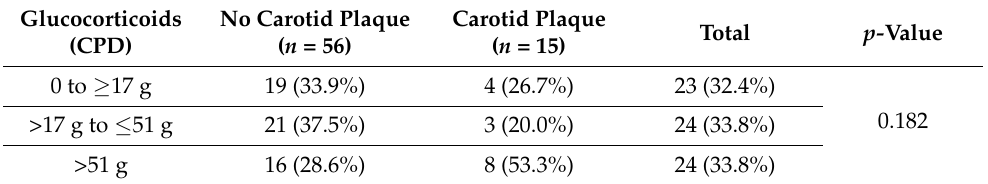
Table 2. Cumulative prednisone classification.